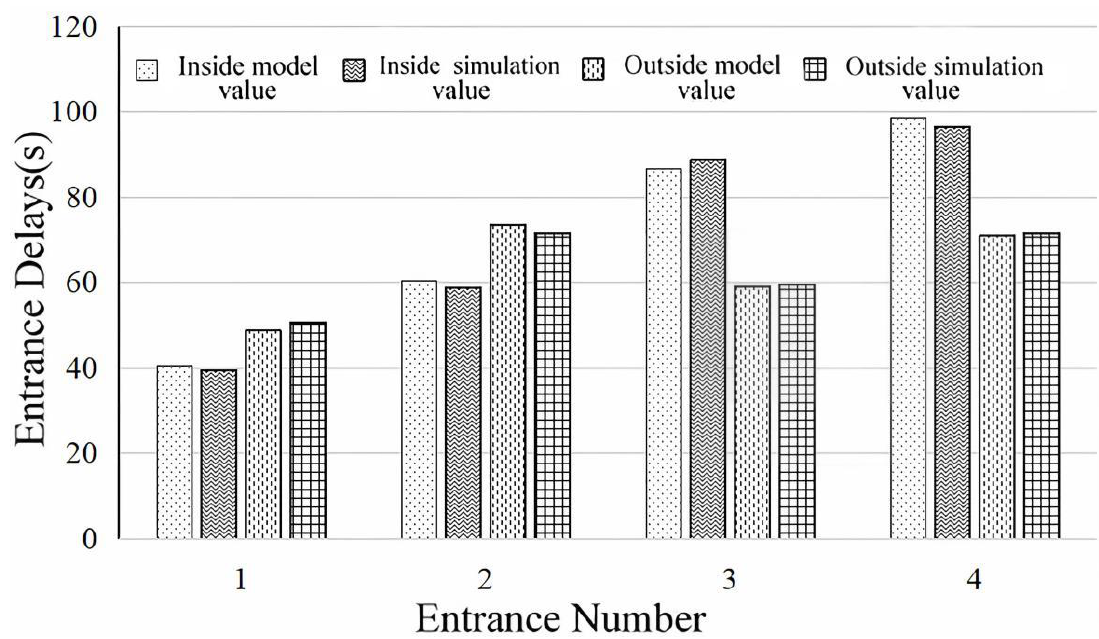
Figure 8. Delay contrast of model value and simulation value.